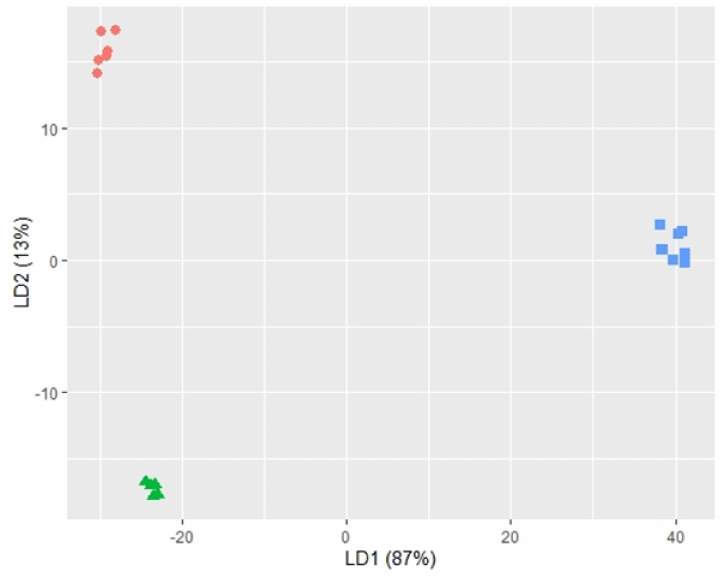
Figure 3. Aroma compounds identified from SPME GC-MS successfully separated the different sound treatments. Log-transformed relative abundance data of the 24 putatively identified aroma compounds from each ferment are projected onto two-dimensional space (following normalisation against an internal standard), resulting in three distinct clusters. Red = high-frequency (10 kHz), green = low-frequency (100 Hz), blue =